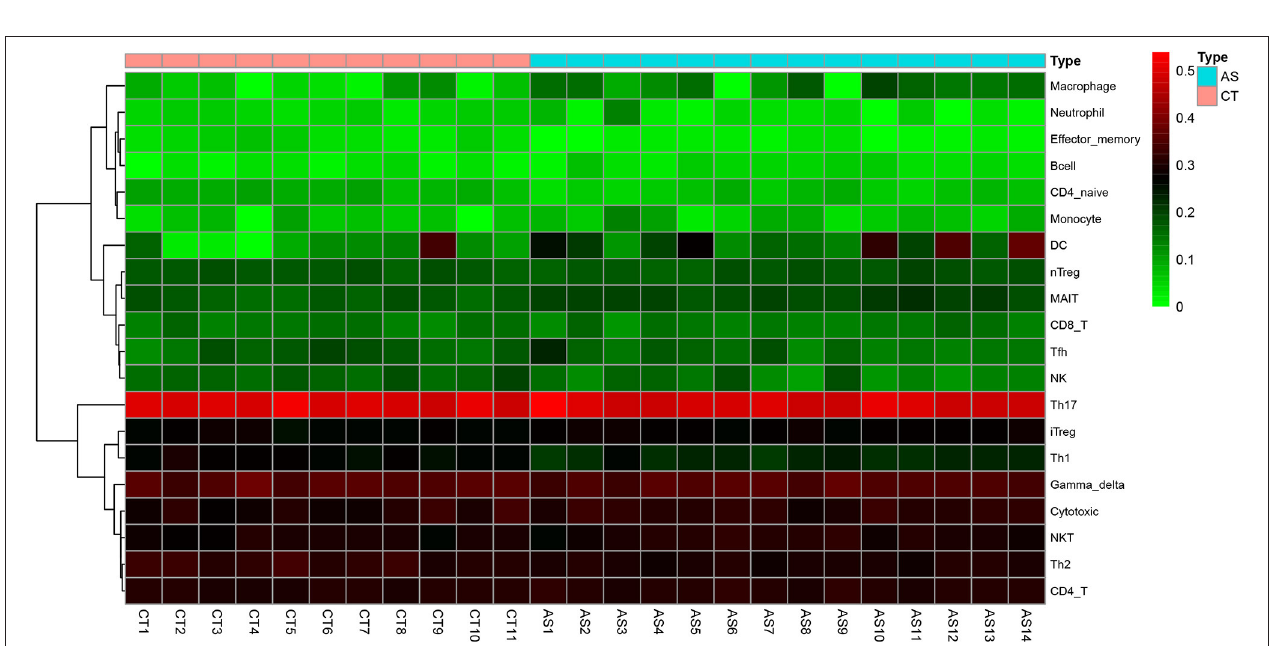
FIGURE 5 | Heatmap of the proportions of 20 immune cell types in the normal group and the AS group.